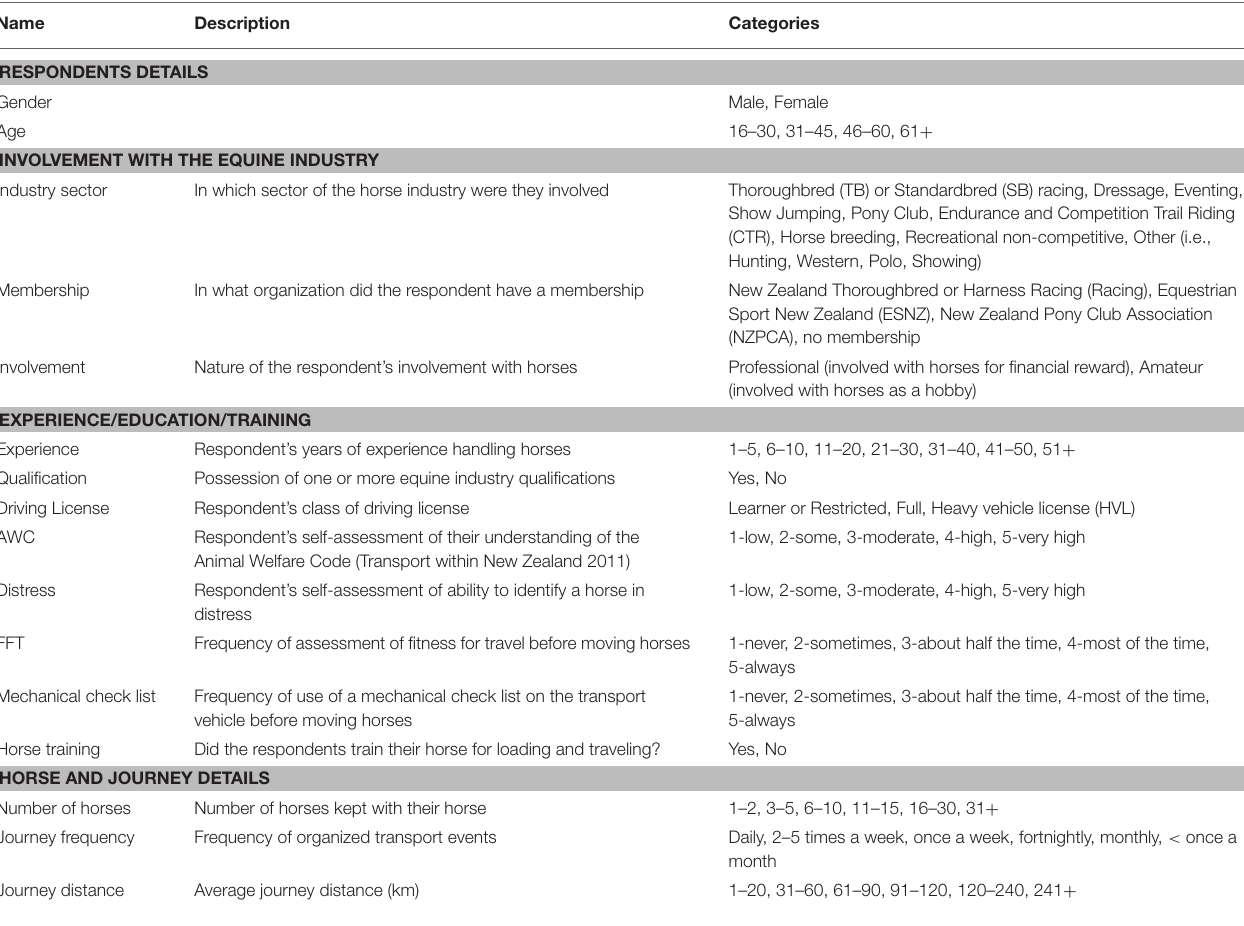
TABLE 1 | Name and description of the candidate explanatory variables